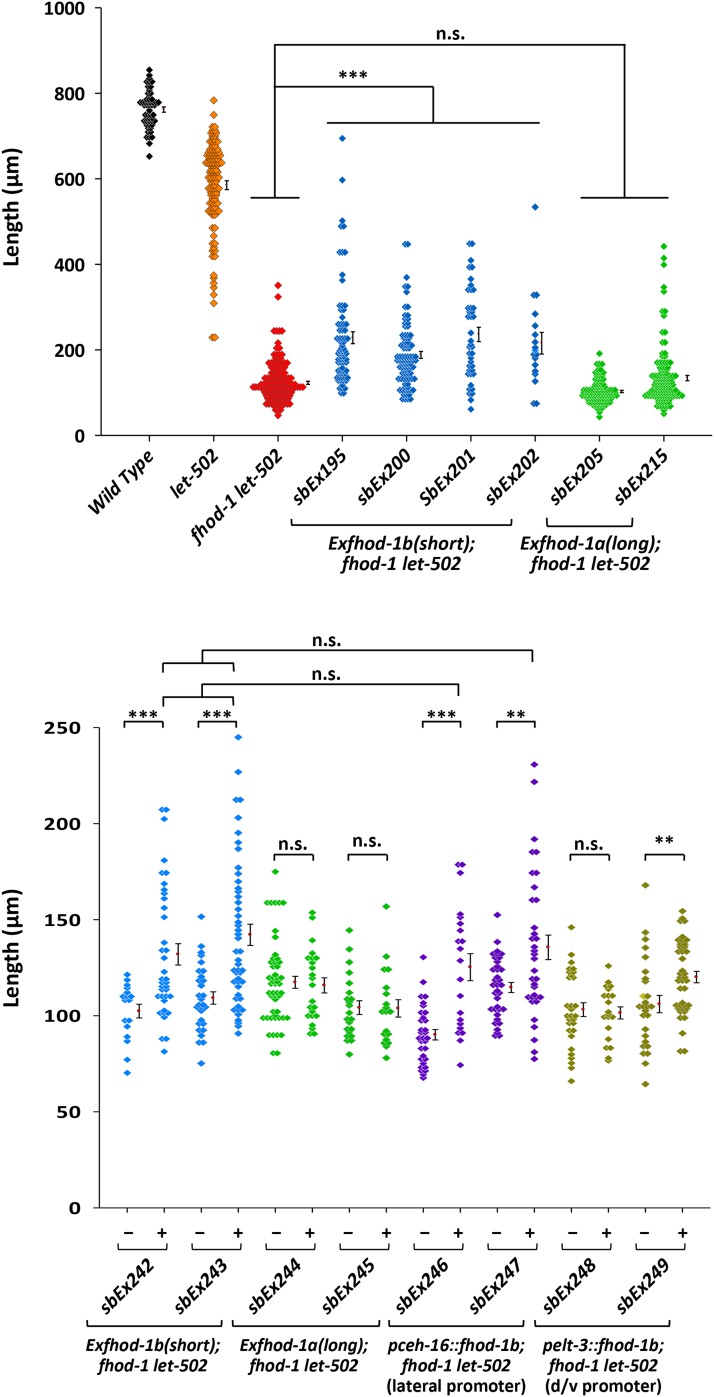
Transgenic rescue by fhod-1 isoforms and tissue-specific rescue. Hermaphrodites were cultured at the semi-permissive temperature of 24° and progeny lengths of semi-synchronized broods were measured 2 days after egg laying (see MATERIALS and METHODS). The null fhod-1(tm2363) was sensitized with the ts allele let-502(sb118). There was little overlap in lengths of let-502 and fhod-1 let-502 controls. (A) Independent extrachromosomal transgenes containing the native fhod-1 promoter driving fhod-1b cDNA without exon 8 (sbEx195, sbEx200, sbEx201 and sbEx202) resulted in far more animals overlapping control let-502 lengths than did cDNAs encoding the longer isoform fhod-1a (sbEx205, sbEx215). (B) Transgenic lines marked with SUR-5::GFP enabled scoring of transgenic progeny in comparison to sibs who did not inherit the array. Rescue was seen among GFP+ progeny for the short (sbEx242, sbEx243) but not the long (sbEx244, sbEx245) fhod-1 isoform under the control of the native fhod-1 promoter. The short isoform was then driven using lateral-specific pceh-16 or dorsal/ventral-specific pelt-3 promoters. Rescue was seen for both lines using the lateral promoter (sbEx247, sbEx248) and was not significantly different from the control lines (sbEx242, sbEx243) that employed the native promoter. One dorsal/ventral line (sbEx249) did rescue, but none of the progeny fell outside the range of the control sibs. Unhatched embryos are ∼50 µm. Error bars = standard error of the mean. Because the lengths did not show normal distributions, the Kruskal-Wallis One Way Analysis of Variance on Ranks was used rather than ANOVA. *** = P < 0.001, ** = P < 0.01, n.s. = P > 0.05, not significant. Supplemental Figure 4 shows comparison of this method of assessing growth to scoring with the dissecting microscope used in Figures 2 and 4.